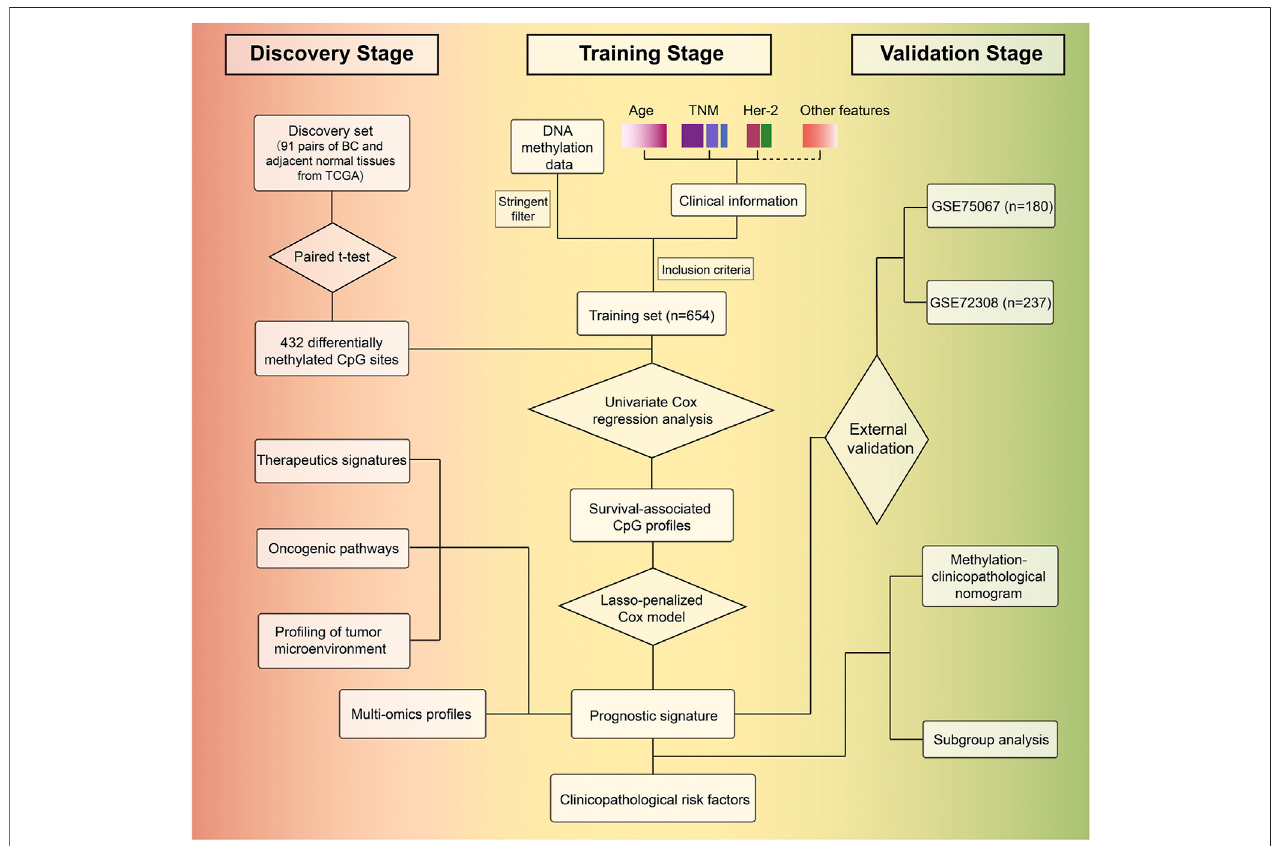
FIGURE 1 | Study overview for pro fi ling the prognostic signature based on large-scale DNA methylation